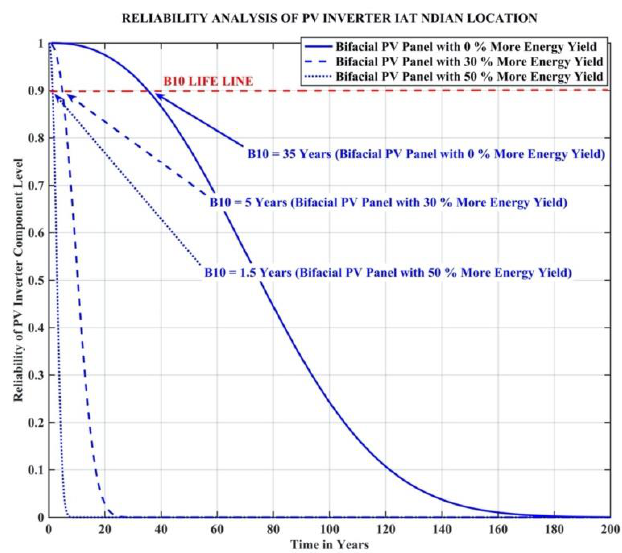
Figure 21. Reliability function of the PV inverter at the location in India (Component Level).